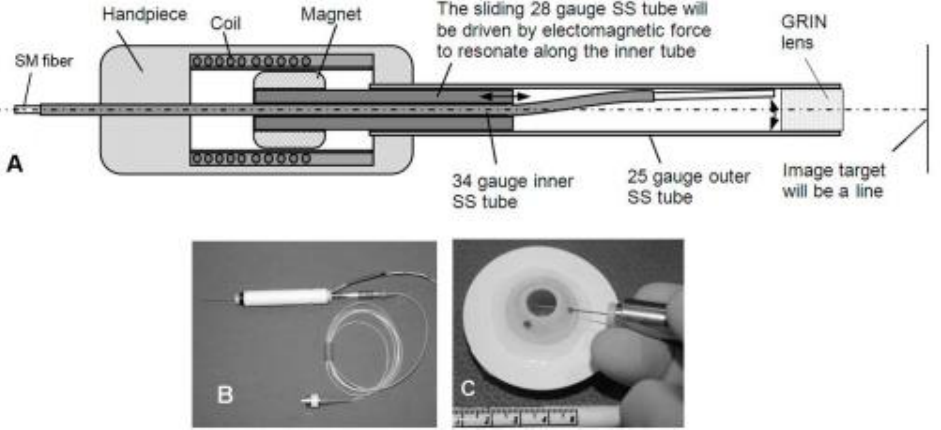
Figure 18. Electromagnetically driven OCT probe: ( A ) schematic; ( B ) developed probe; ( C ) test of probe through a 25-gauge port (taken with the permission of [113] © The Optical Society).